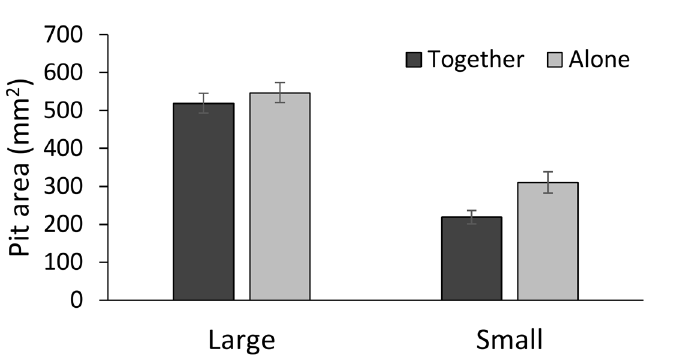
Figure 3. ( a ) Pit area was dictated by sand depth: larger and smaller in the deep and shallow sand treatments, respectively, and variable in the choice treatment, depending on whether deep or shallow sand was chosen. ( b ) Large wormlions remained in the initial placement location (in deep sand) more frequently than expected by chance, independent of whether all wormlions were placed simultaneously or not. ( c ) Pits constructed by large and small wormlions in shallow sand were of a similar area, but large wormlions constructed larger pits in deep sand. ( d ) The interaction between treatment (whether wormlions were placed simultaneously or not) and the difference between pit area in deep and shallow sand. The largest difference was obtained when the large wormlions were placed 2 h before the small ones. Means ± 1 SE are presented.